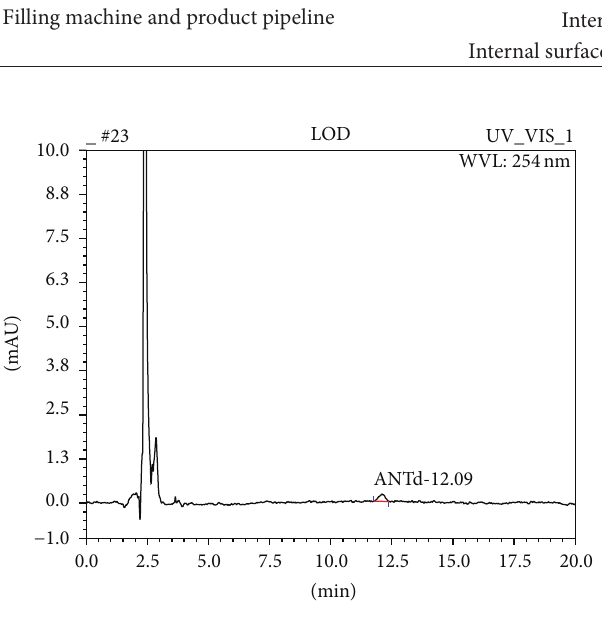
Figure 9: LOD solution (0.0466 𝜇